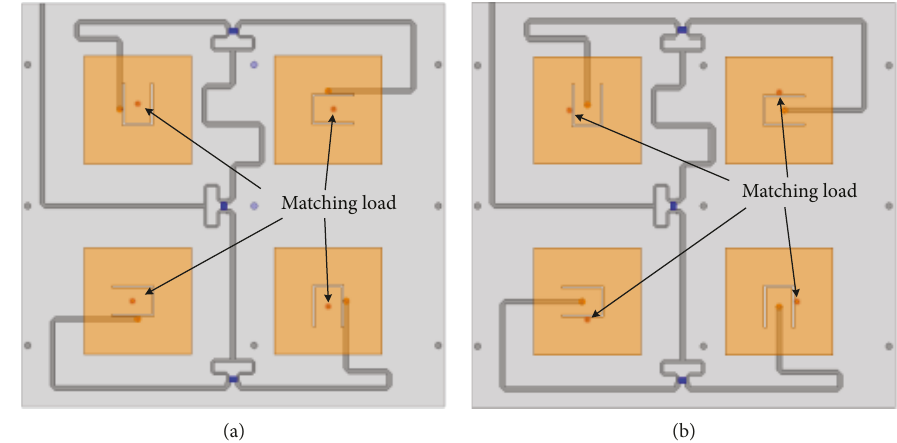
Figure 7: Respective excitations for the array: (a) Only feed_1 is excited; (b) only feed_2 is excited.